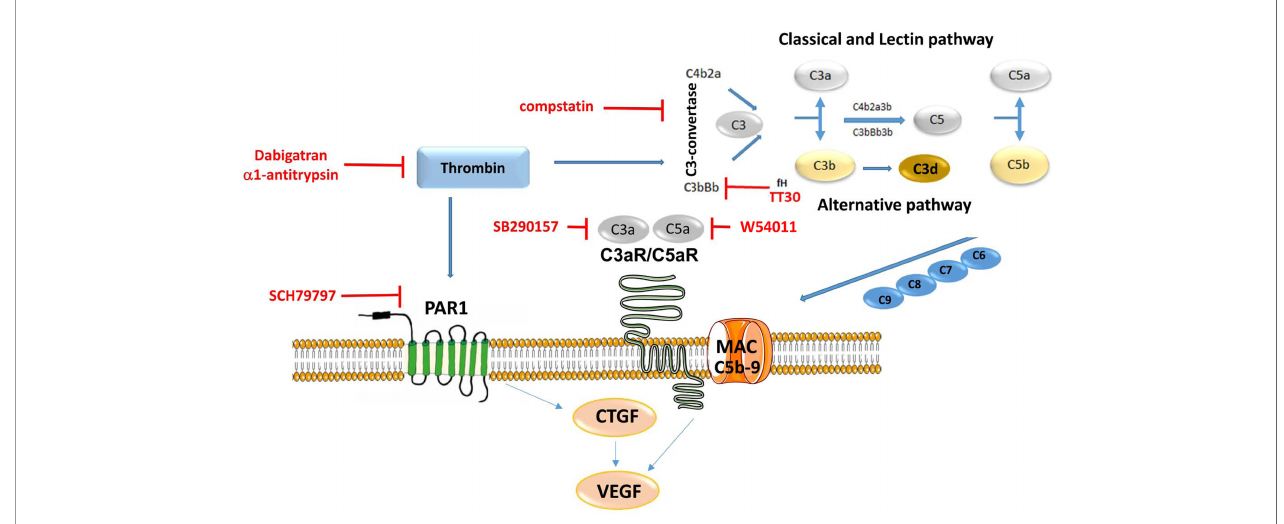
FIGURE 9 | Summary Figure. Thrombin regulates a dual-signaling mechanisms, by cleaving C3 and C5, it activates the complement cascade, and it modulates down- stream signaling via membrane-bound receptor PAR1. Inhibitors are presented in red and pathways are presented in blue. The study concluded that thrombin induces complement and CTGF, which subsequently activates VEGF secretion in ARPE-19 cells, resulting in disassembly of tight junctions and TER